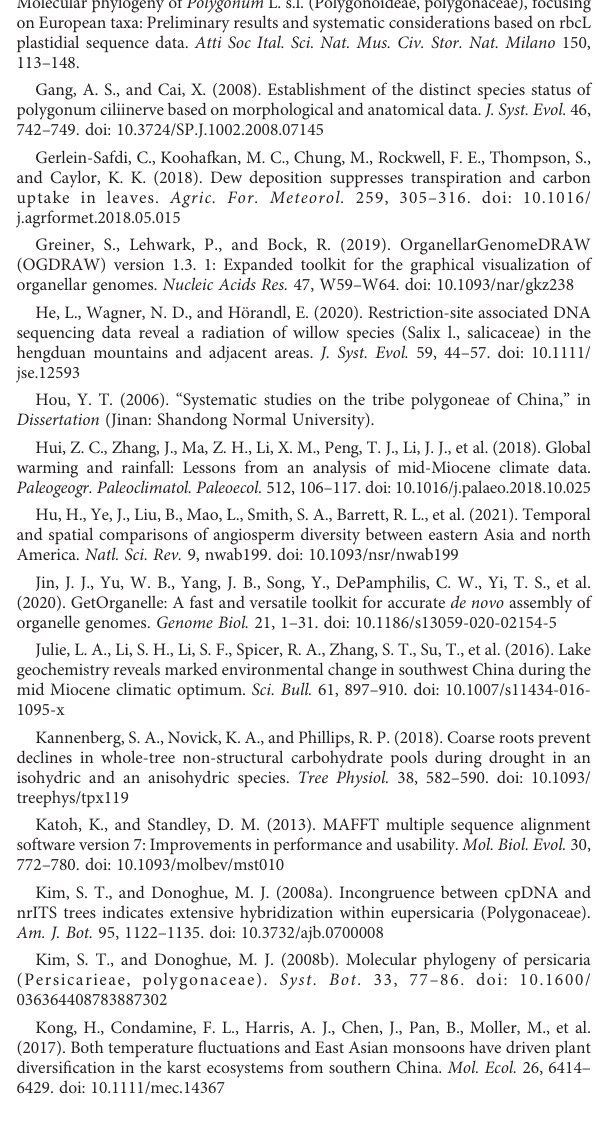
SUPPLEMENTARY FIGURE 4 MLphylogenetic treeinferredfrom80 individualsbasedon79PCGs using RAxML. Numbers next to each node denote bootstrap support values. SUPPLEMENTARY FIGURE 5 ML phylogenetic tree of 80 individuals based on noncoding plastome sequences. SUPPLEMENTARY FIGURE 6 Species tree inferred from 79 PCGs using ASTRAL. Numbers next to each node are the posterior probability